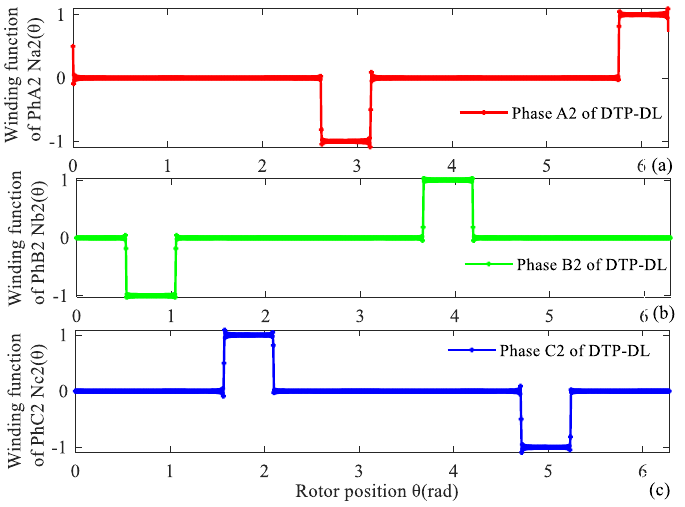
Figure 3. Winding function of second group of DTP-DL winding. ( a ) A2, ( b ) B2, ( c ) C2.